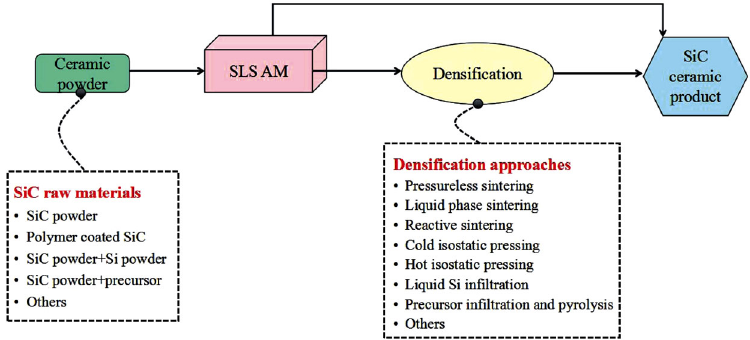
Fig. 12 Schematic drawing of the SLS of SiC